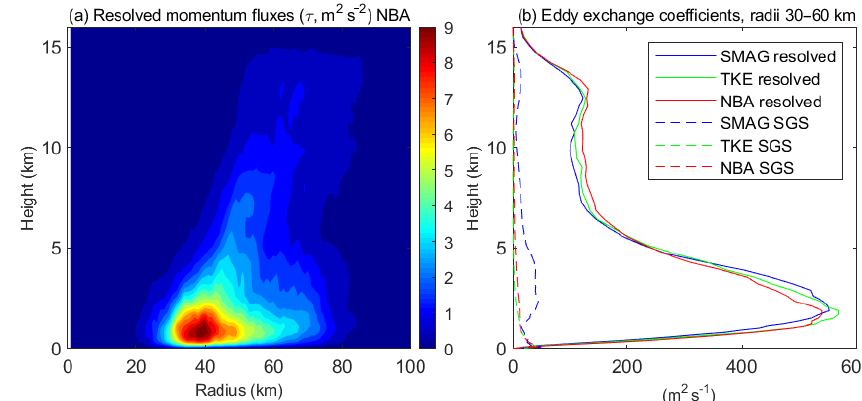
2 + 2 1 w (cid:48) v (cid:48) ) 2 , induced by the resolved